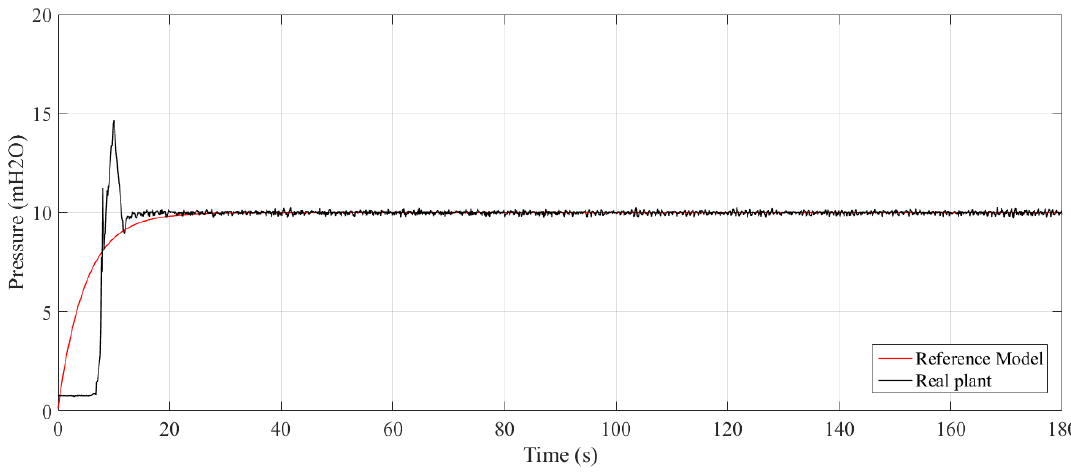
Figure 7. Step response to N = 1 and σ = 10.